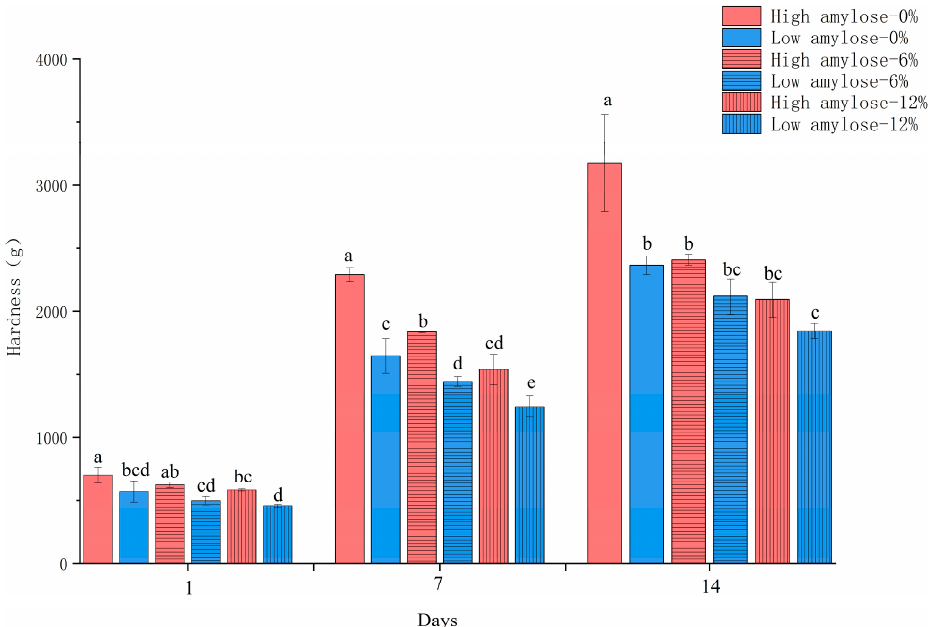
Figure 1. Hardness changes during high-amylose and low-amylose RRF gels storage with different protein fractions (wt%). Each column represents the mean ± standard deviation. The columns were compared on days 1, 7, and 14, and those with different letters denote where the means are significantly different ( p < 0.05).